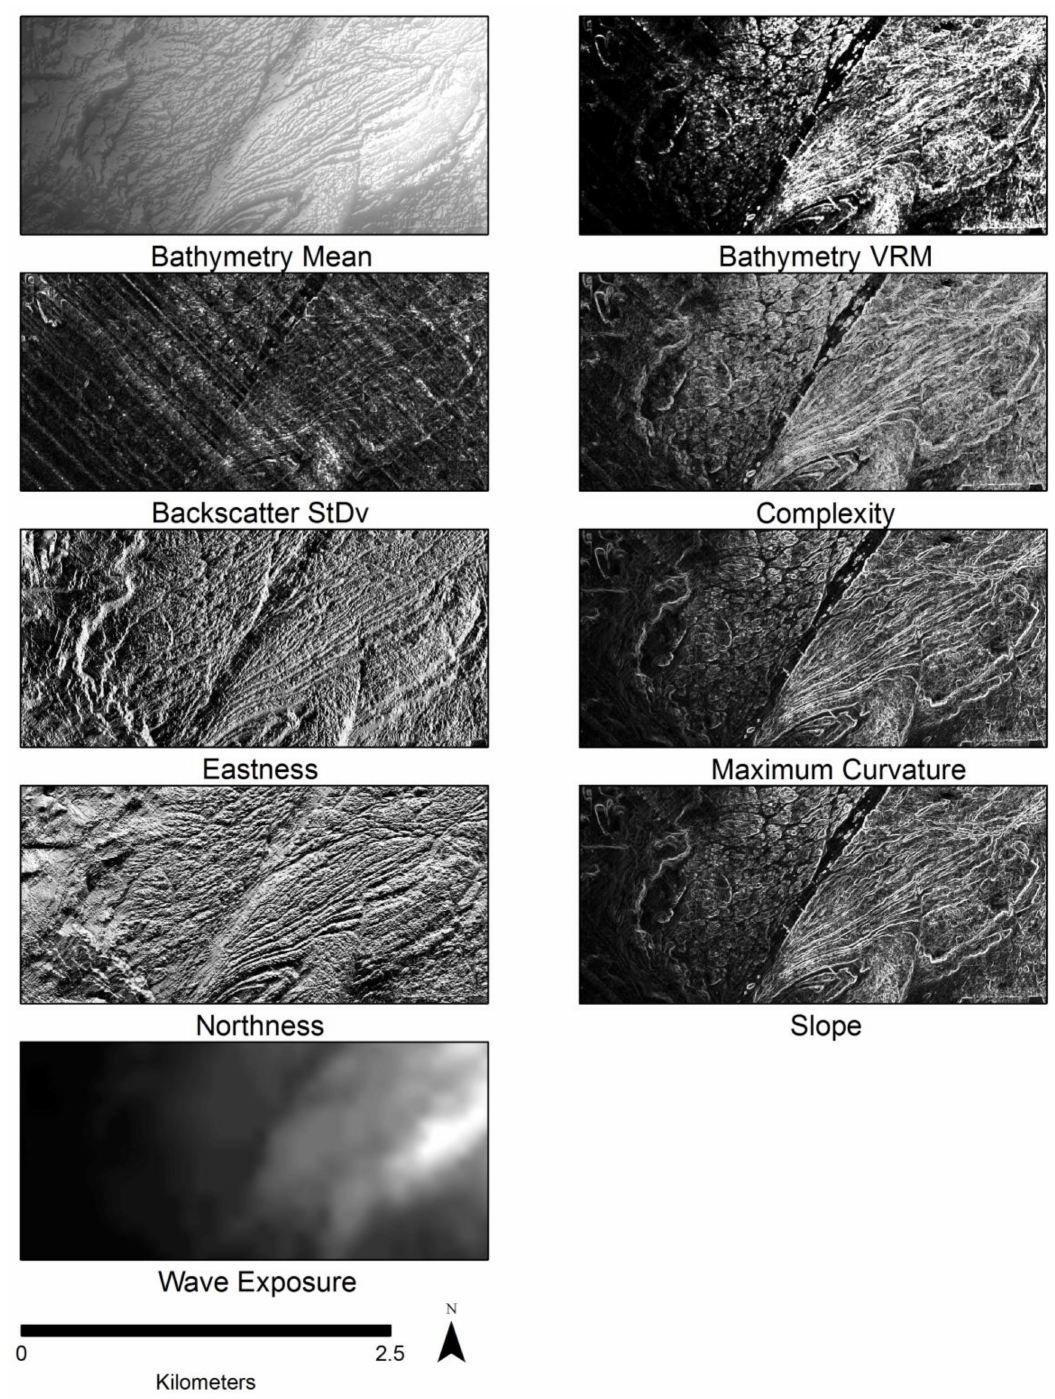
Figure 2. Example of derivative surfaces selected for use in hierarchical models. Scale of analysis for examples is 3 ×